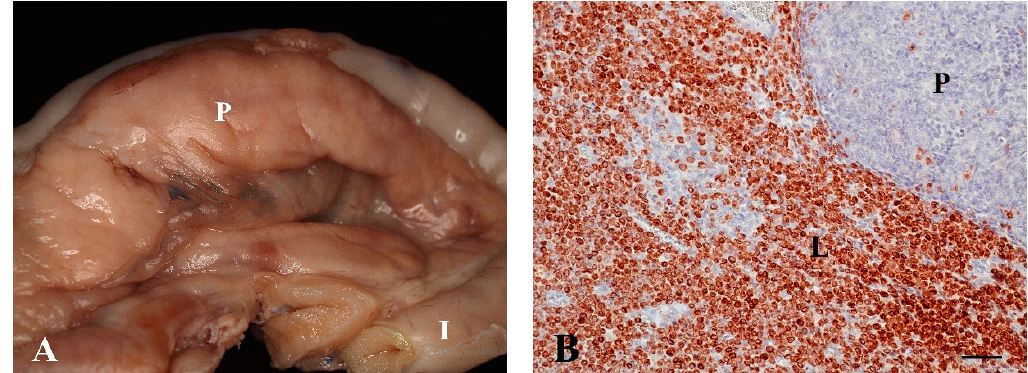
Figure 1. ( a ) T-cell lymphoma. The pancreas (P) close to the small intestine (I) is enlarged, white